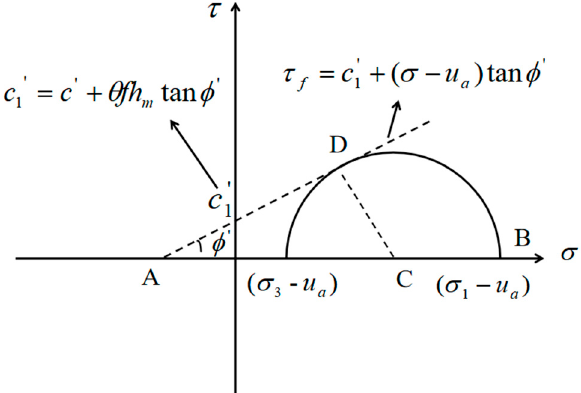
Figure 1. Mohr stress circle expression of failure envelope in two-dimensional plane of net normal stress and shear stress of unsaturated soil.